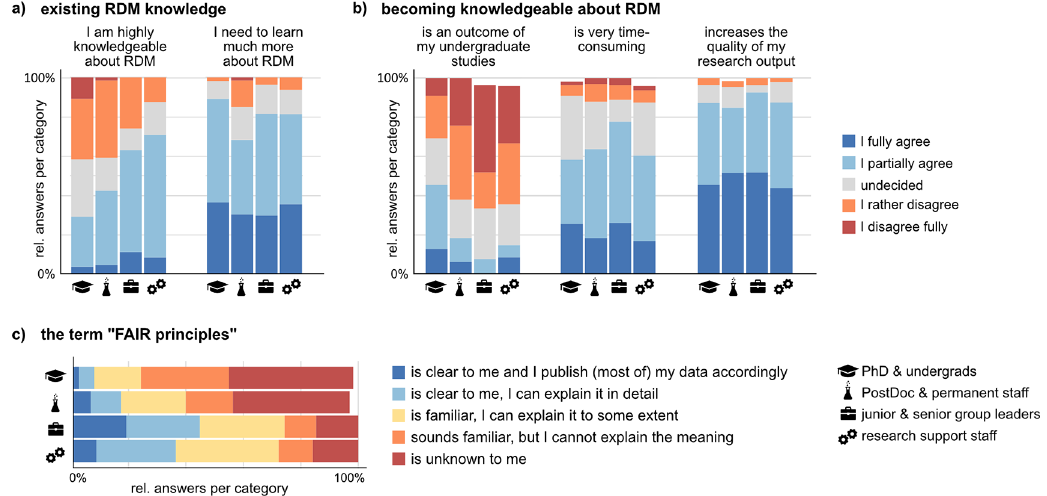
Figure 7. RDM knowledge and the FAIR (finable, accessible, interoperable, reusable) principles. a, b) Respon- dents provided their opinion about presented statements on a five-item scale. See Suppl. Figure 11 for the full set of questions. Shown are the relative fraction per answer item in each group (undergraduate and PhD student, n = 55; Postdoctoral and permanent researchers, n = 66; Junior and senior group leaders, n = 27; Research support and facility staff, n = 50). c) Respondents were asked about their adoption and knowledge of the FAIR principles on the indicated five-item answer